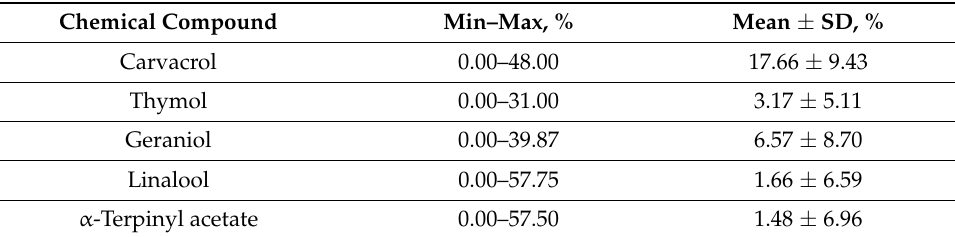
Table 2. Variation of main chemical compounds of essential oils in T. pulegioides habitats ( n = 131) (SD—standard